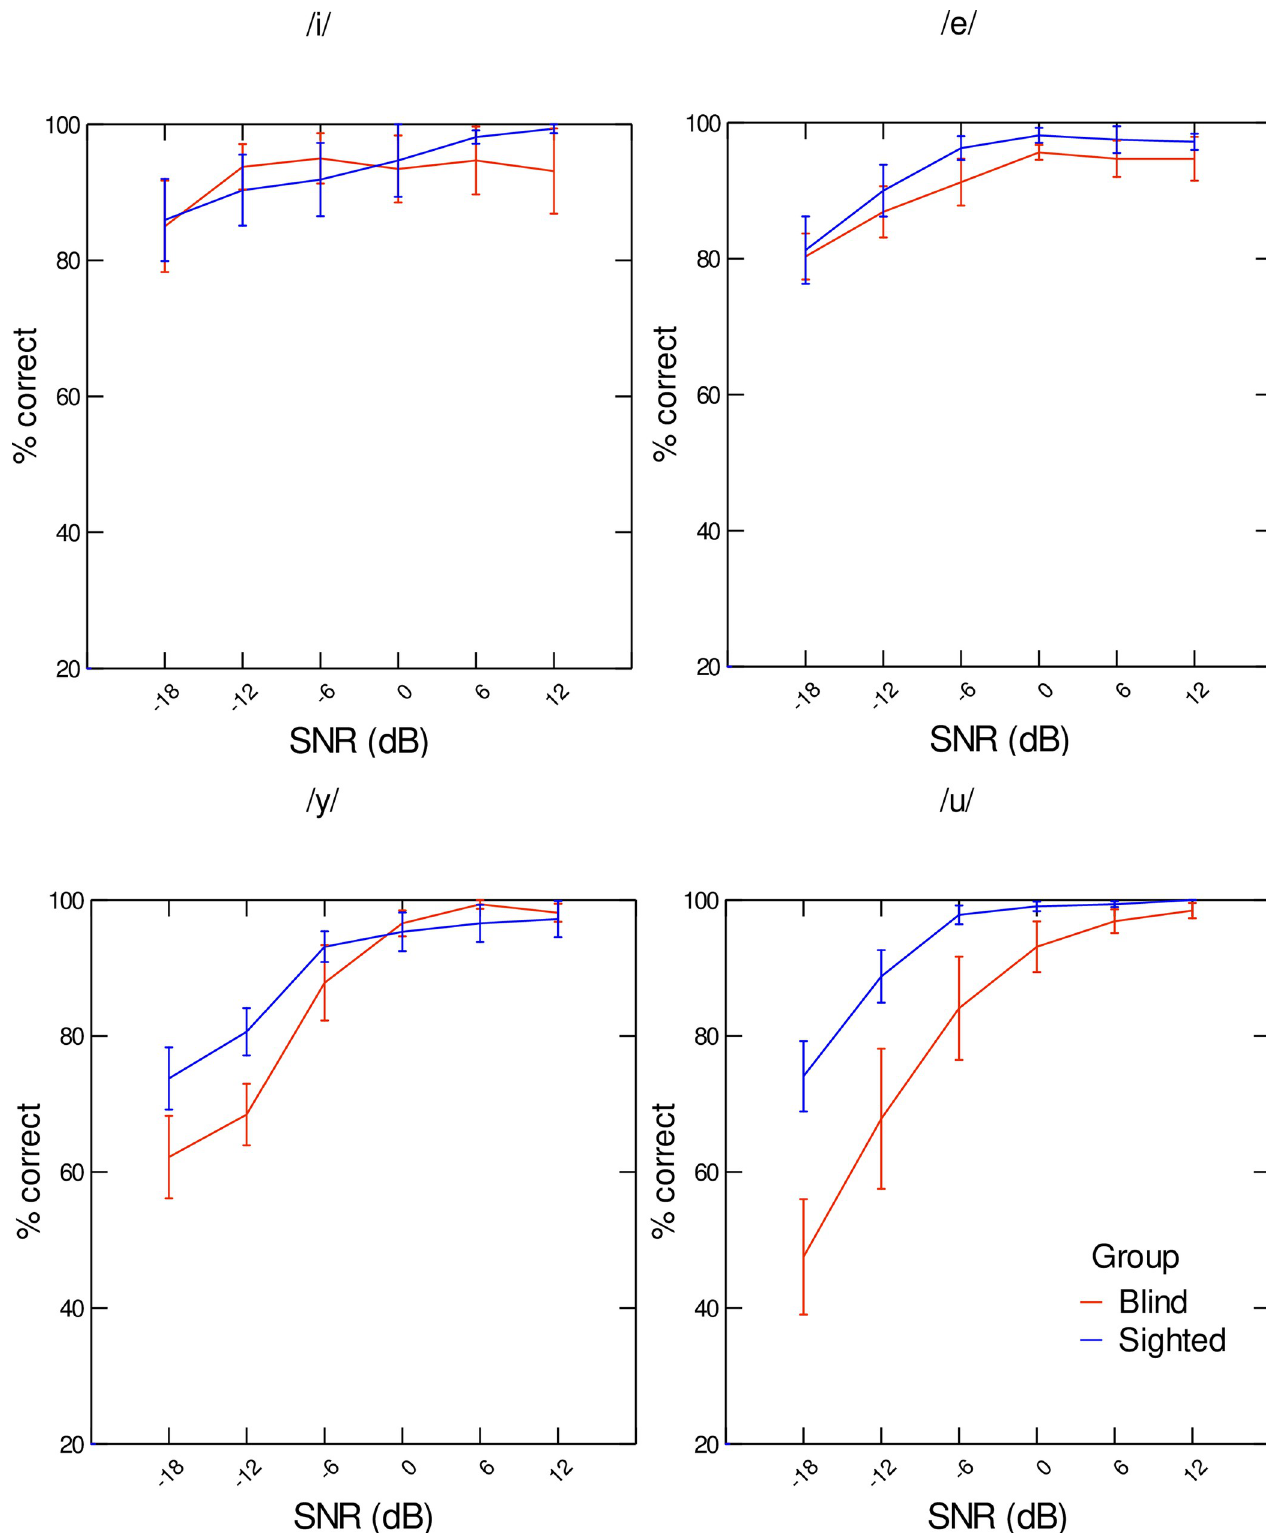
Fig 6. Percentages of correct responses (intelligibility scores) per SNR level, averaged across listeners, for the vowels /i/ (a), /e/ (b), /y/ (c), and /u/ (d).